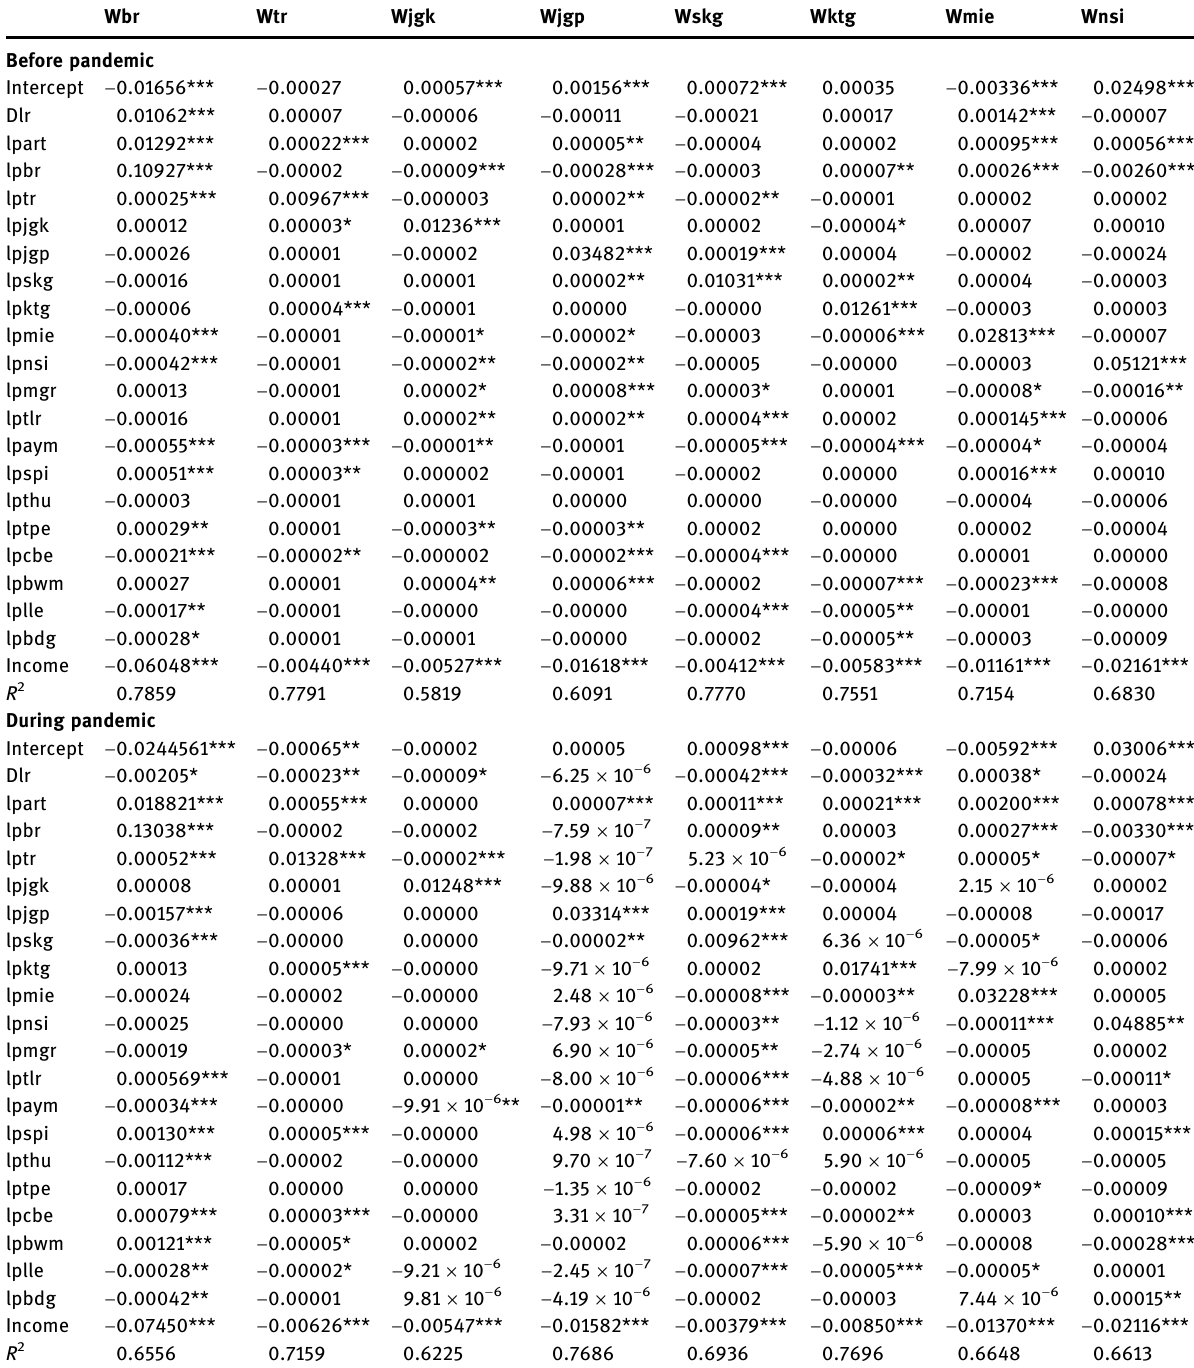
Table 2: Determinants of carbohydrate - source food consumption in Central Java before and during the COVID - 19